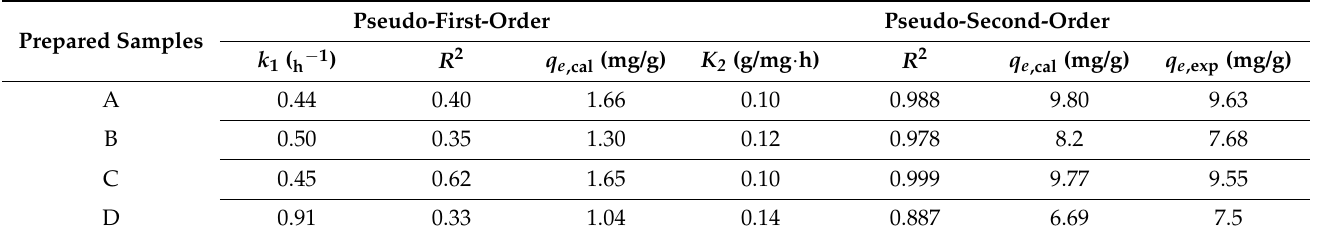
Table 5. Parameters were evaluated using the pseudo-first-order and pseudo-second-order kinetic models.